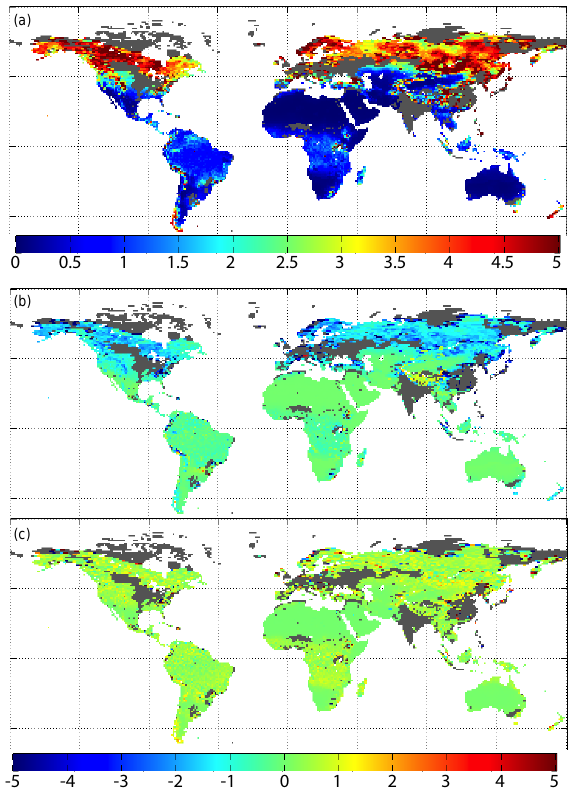
Figure 6. Ensemble–mean combustible fuel load in kgCm − 2 and change due to climate and CO 2 effects. (a) Average emissions 1971–2000; (b) change from 1971–2000 to 2071–2100 for RCP8.5 due to climate effect; (c) same as (b) but due to CO 2 effect. Grey ar- eas have no fire or are excluded as dominated by agriculture. Com- bustible fuel load is the amount of carbon potentially emitted if a fire occurs.